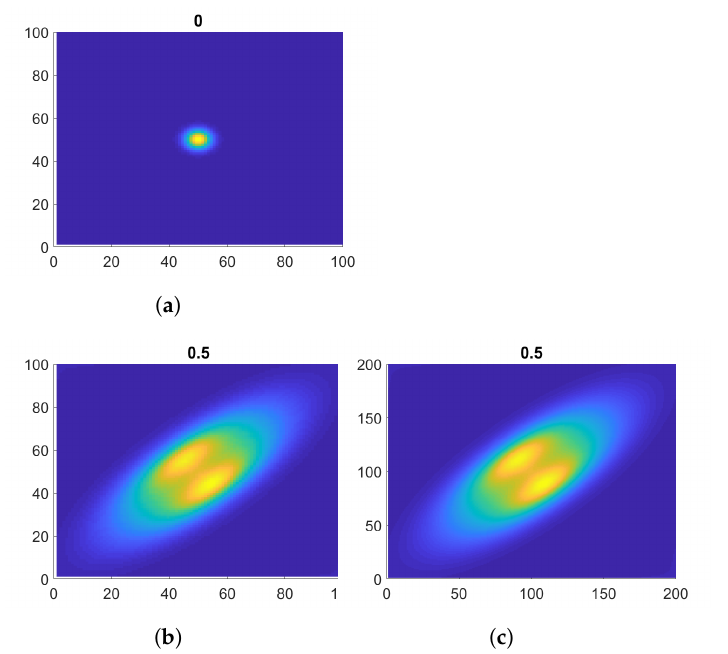
Figure 2. Numerical test. ( a ) Initial condition as a Gaussian centered in the domain. ( b ) Grid size of 100 × 100, numerical result at time t = 0.5. ( c ) Grid size of 200 × 200, numerical result at t =